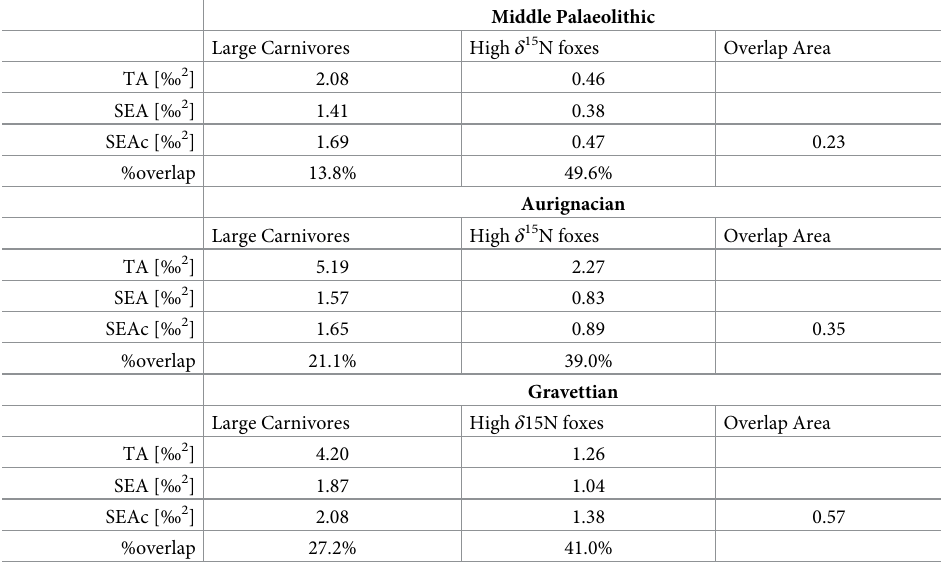
Table 3. Calculated niche overlap between large carnivores and high δ 15 N foxes, based on SIBER.